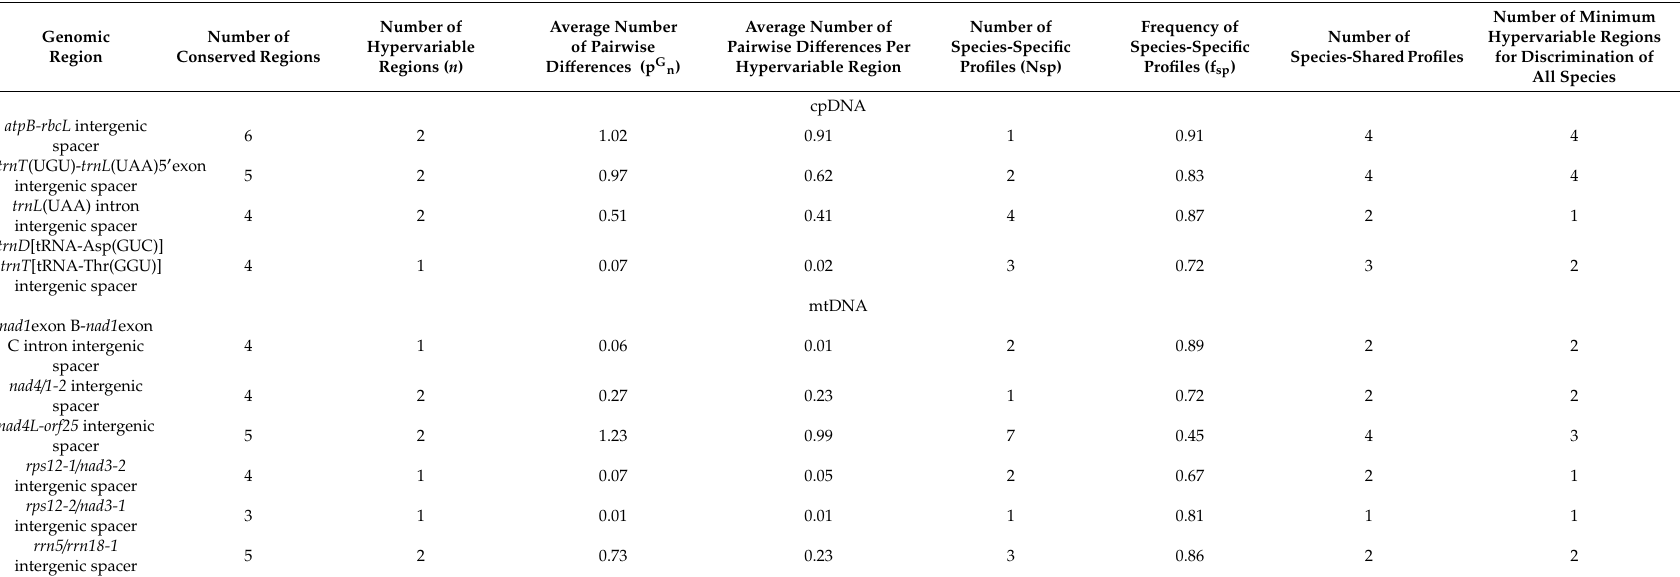
Table 1. Main SPInDel analyses performed for each cpDNA and mtDNA target region for 35 accessions of 13 Secale